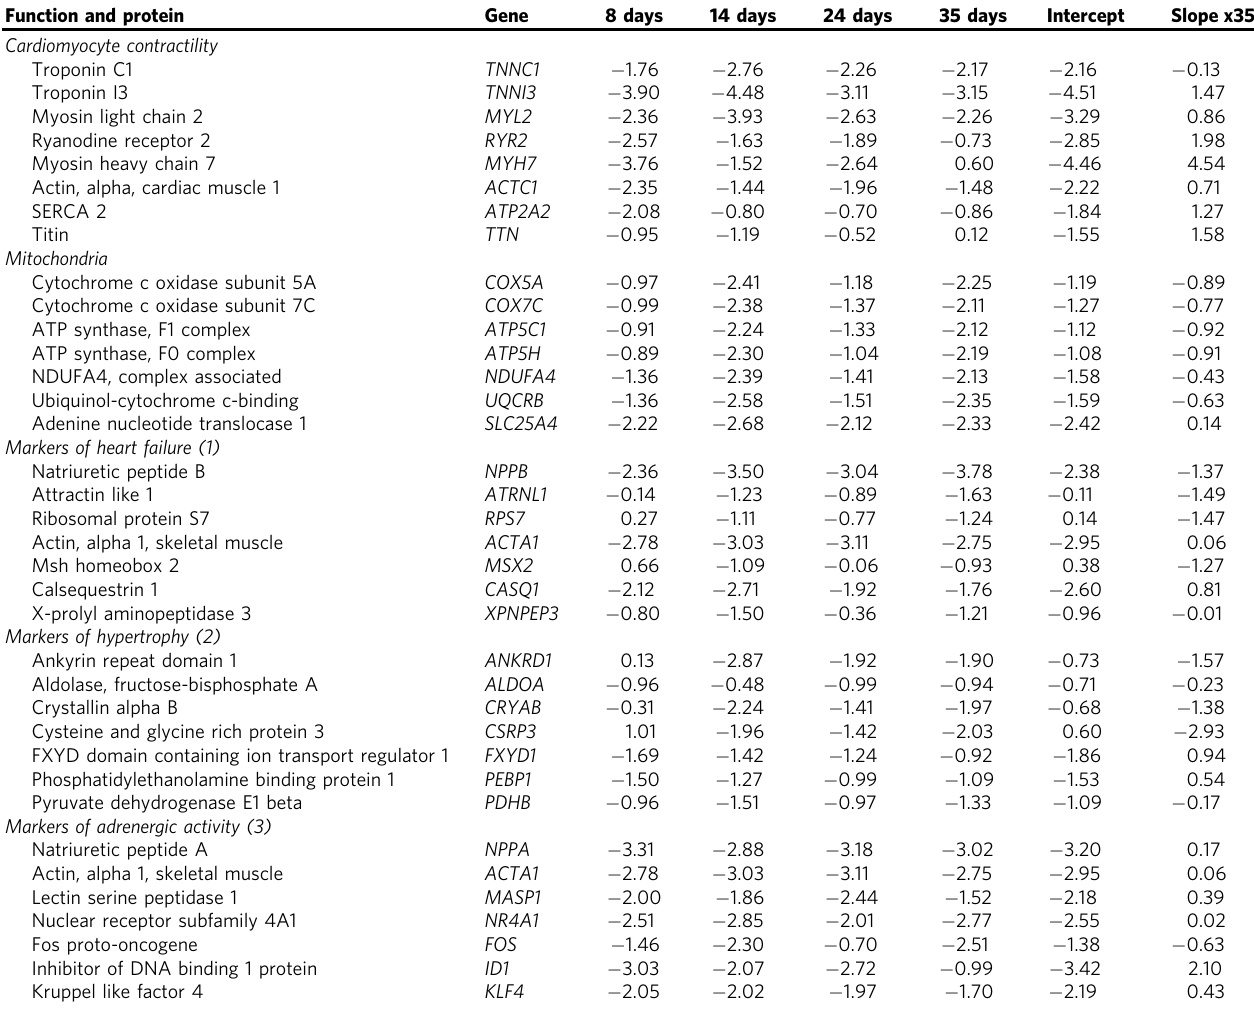
Table 1 Time course of mRNA expression in cultured